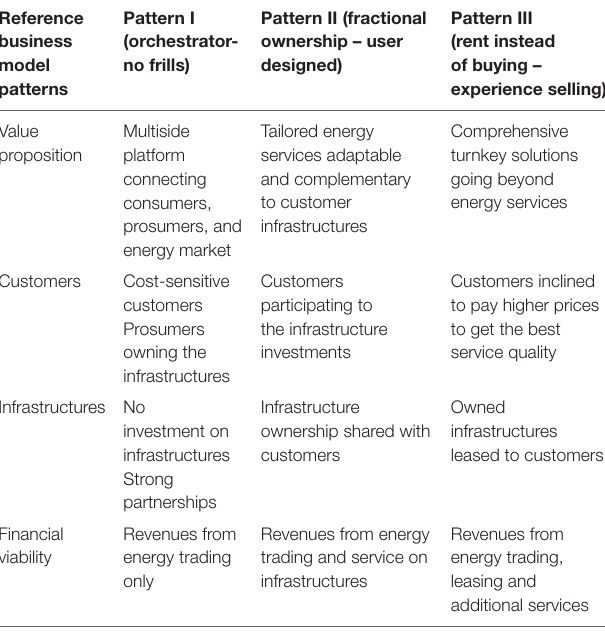
TaBle 2 | Main features of the identified reference business model patterns (Facchinetti and sulzer,